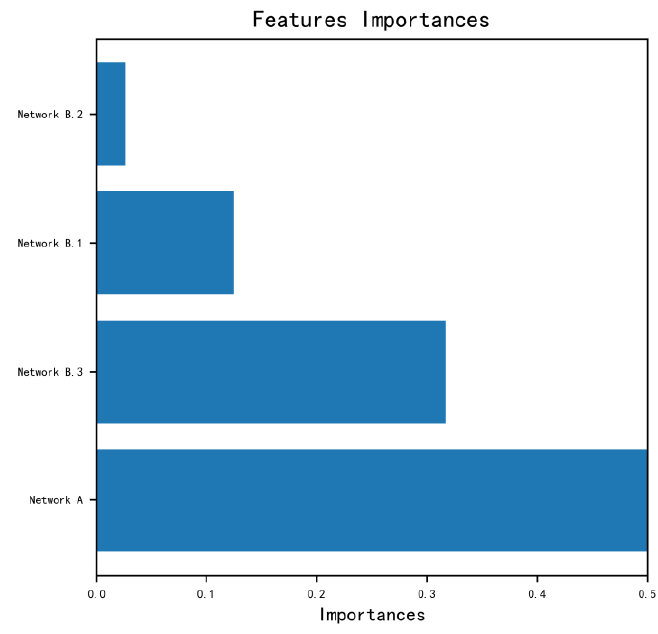
Figure 2. The feature importance obtained from ensemble learning. For screening genetic diseases, the optimal algorithm Fgds-EL achieves an area under the receiver operating characteristic curve (AUC) of 0.986, a sensitivity of 0.92, and a specificity of 0.97 in the test set. We also calculate the performance of each subnetwork to find out how different parts of the fetal face affect the screening for genetic diseases. Network A achieves the best performance in the subnetwork, including an AUC of 0.857, a sensitivity of 0.76, and a specificity of 0.81 by training subgraph A. Network B.1 achieves an AUC of 0.889, a sensitivity of 0.78, and a specificity of 0.86 by training subgraph B1, and Network B.2 obtains an AUC of 0.66, a sensitivity of 0.70, and a specificity of 0.63 by training subgraph B2. In the bone detection subgraph, Network B.3 attains an AUC of 0.711, a sensitivity of 0.52, and a specificity of 0.93 by training subgraph B3. Network B.1 shows the best performance in subnetworks, which indicates that subgraph B1 contains information that is essential for screening genetic diseases. Further information encompassing the F1 score of Fgds-EL and the subnetwork is also displayed in Table 2. The distribution of the predicted scores and the confusion matrices related to the cate- gories determined by the Fgds-EL and sub-networks in test sets are shown in Figure 4a,b. With the threshold set at 0.3, the percentage of correctly classified images in genetic dis- ease was 92.1% (58/63) in Fgds-EL. By comparison, those correctly classified were 76.2% (48/63) in Network A (threshold = 0.7), 77.8% (49/63) in Network B.1 (threshold = 0.47), 71.4% (45/63) in Network B.2 (threshold = 0.6), and 52.4% (33/63) in Network B.3 (threshold = 0.56),